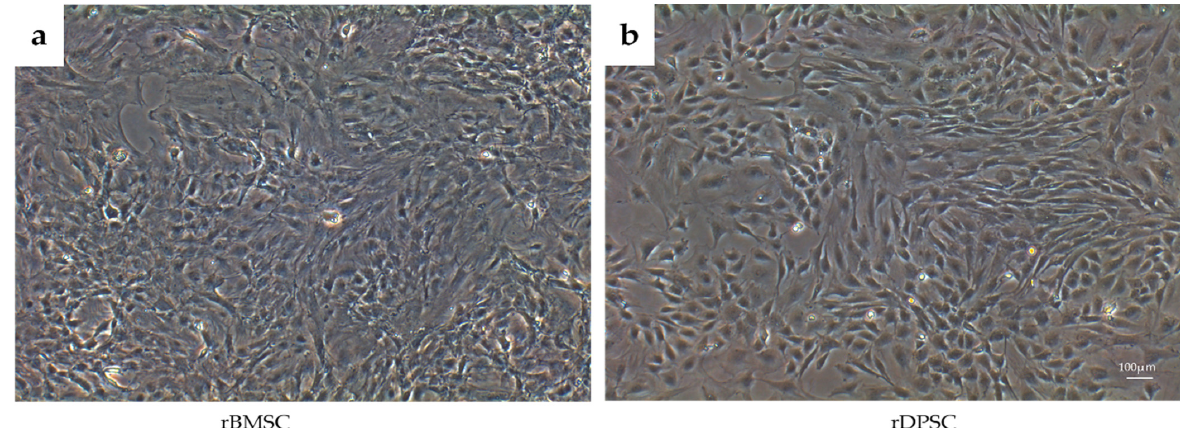
Figure 1. Morphology and proliferation of rBMSCs and rDPSCs. Cells showed a spindle-like fibrous morphology of uniform shape and size. ( a ) rBMSC cells after 3 days of culture; ( b ) rDPSC cells after 3 days of culture (Scale bar = 100 µm).